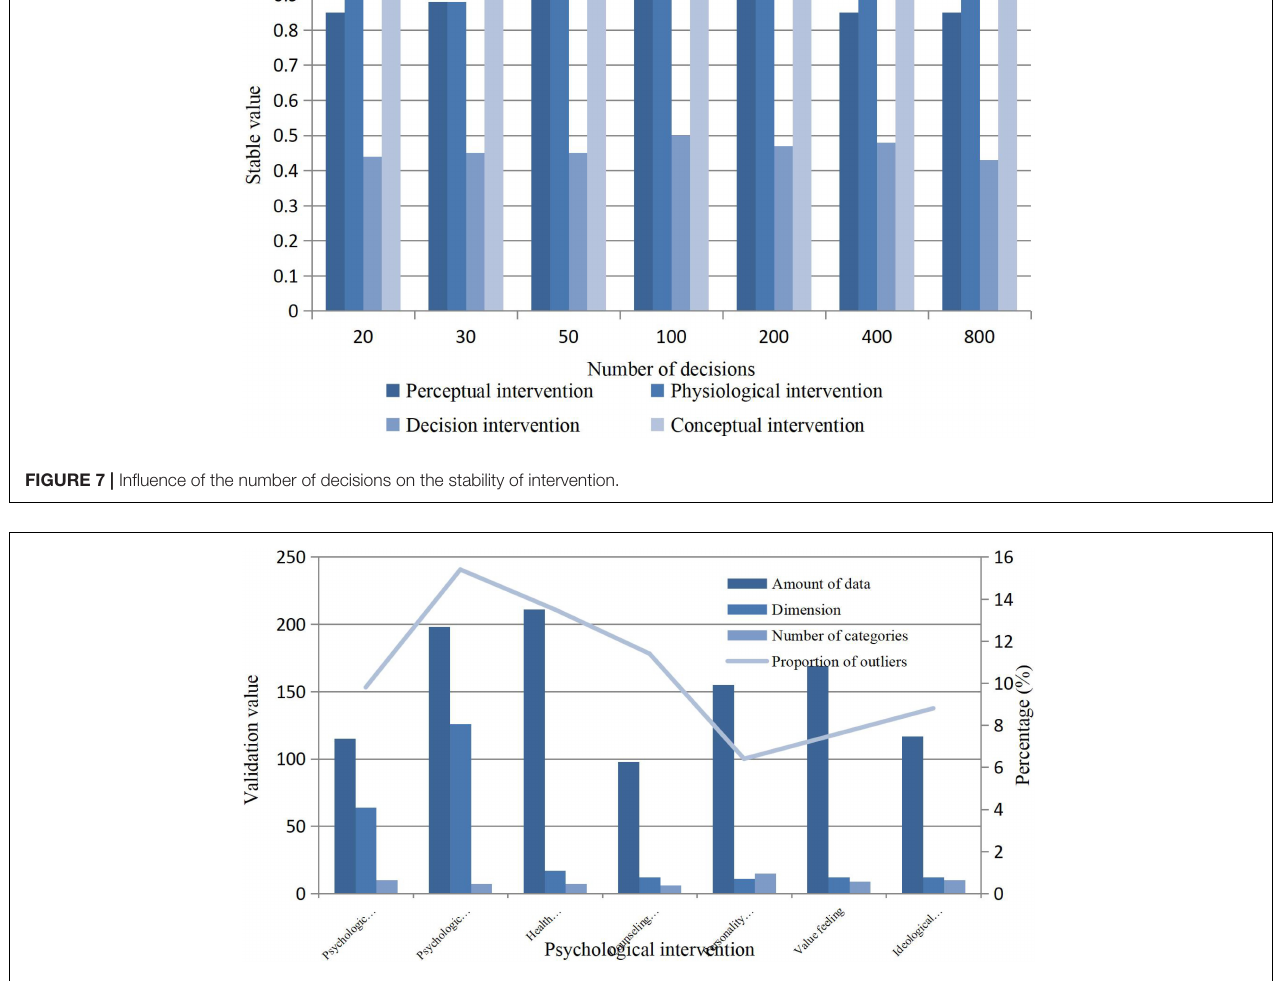
FIGURE 8 | The intervention mechanism data